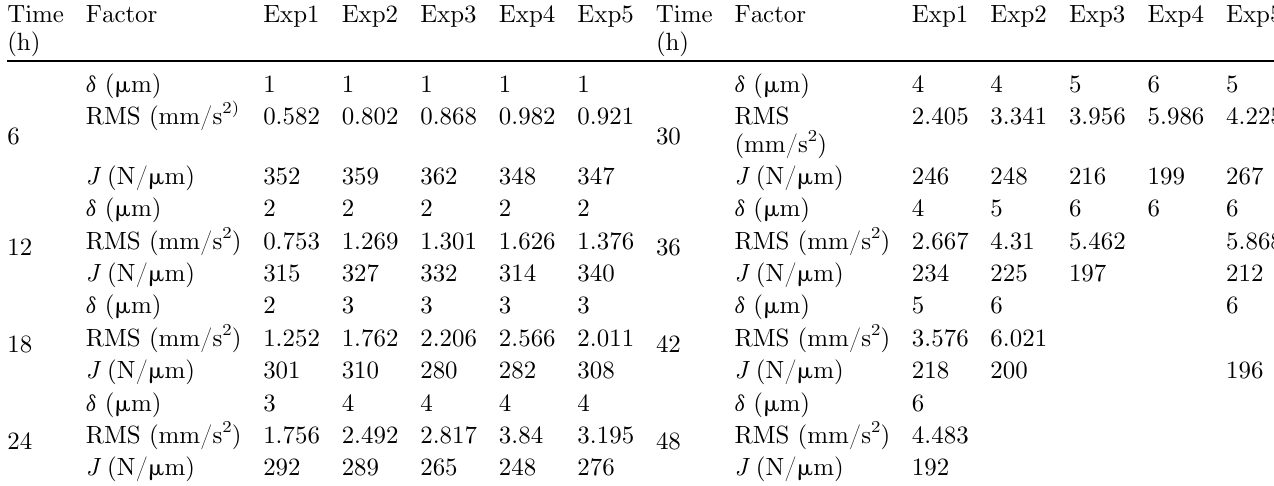
Table 3. Experimental